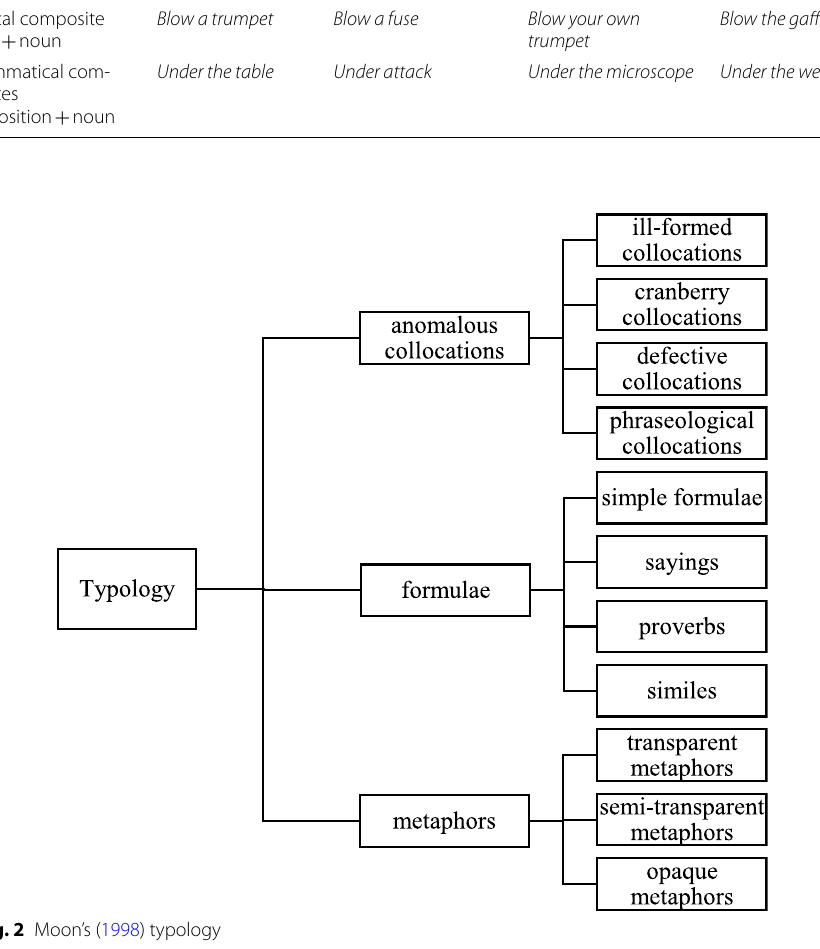
Fig. 2 Moon’s (1998)